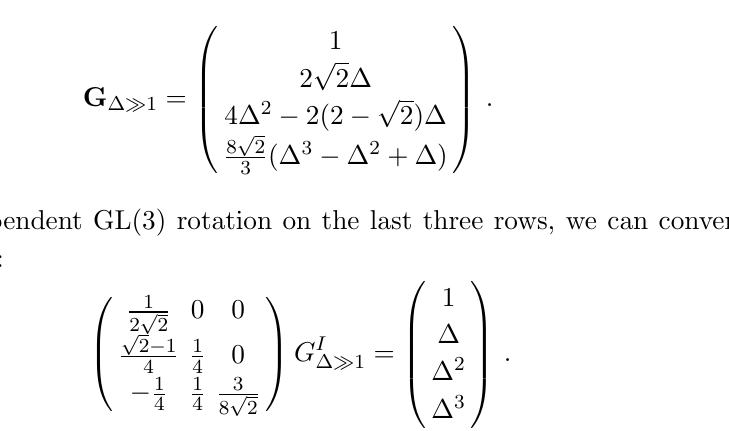
0) and the lower bound given by p 2 ((cid:1) !